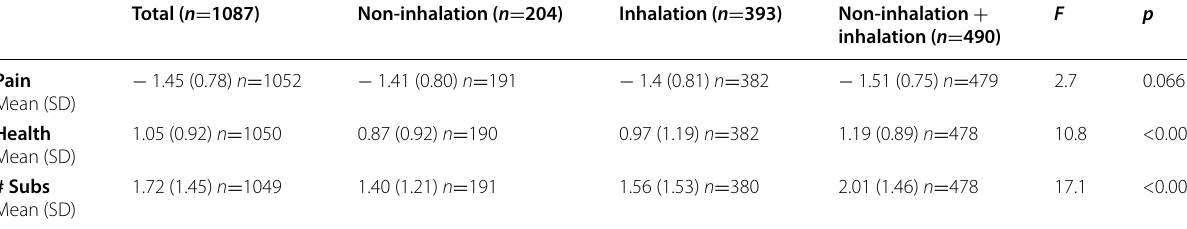
Self-reported changes in pain and health among subgroups of cannabis use